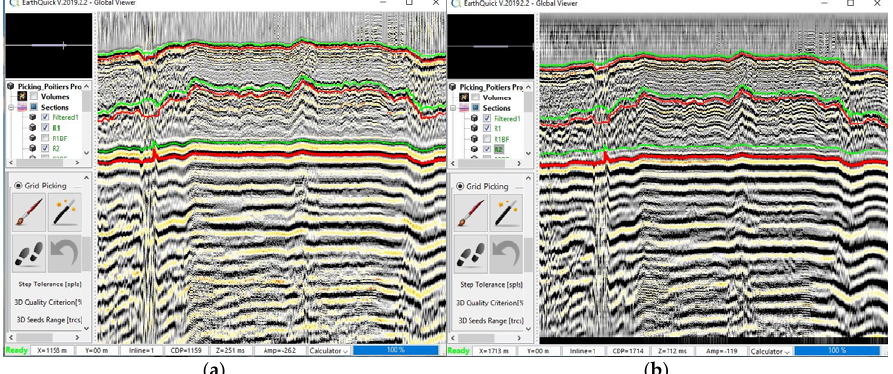
Figure 8. Screenshots of acoustic sections and picked times of the different wave trains by EarthQuick software. Vertical axis: time, horizontal axis: depth, ( a ) 3 m offset section (R1), ( b ) 3.25 m offset section (R2).